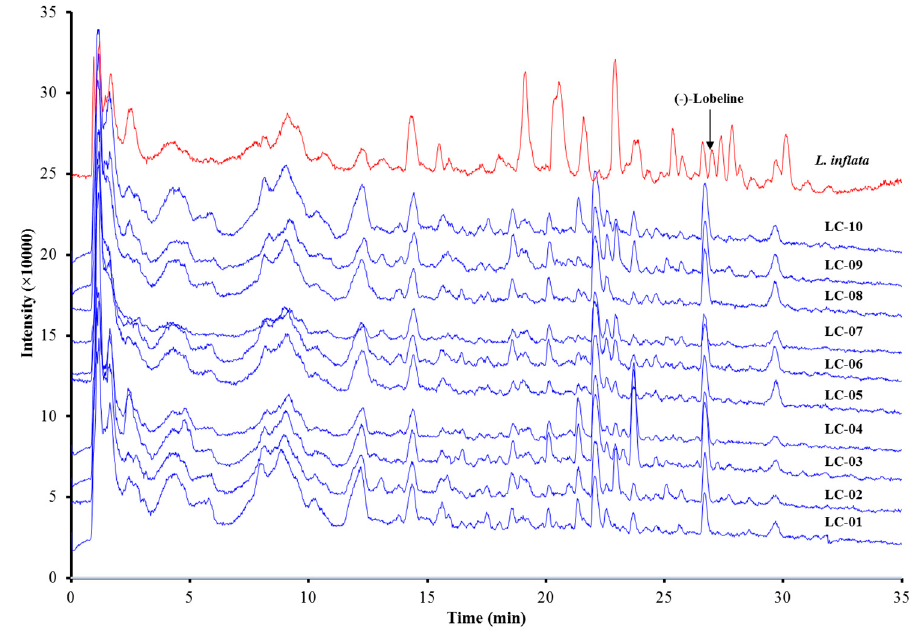
Figure 4. TIC chromatograms of 10 batches of L. chinensis (LC 01-10) and one batch of L. inflata in positive ionization mode.